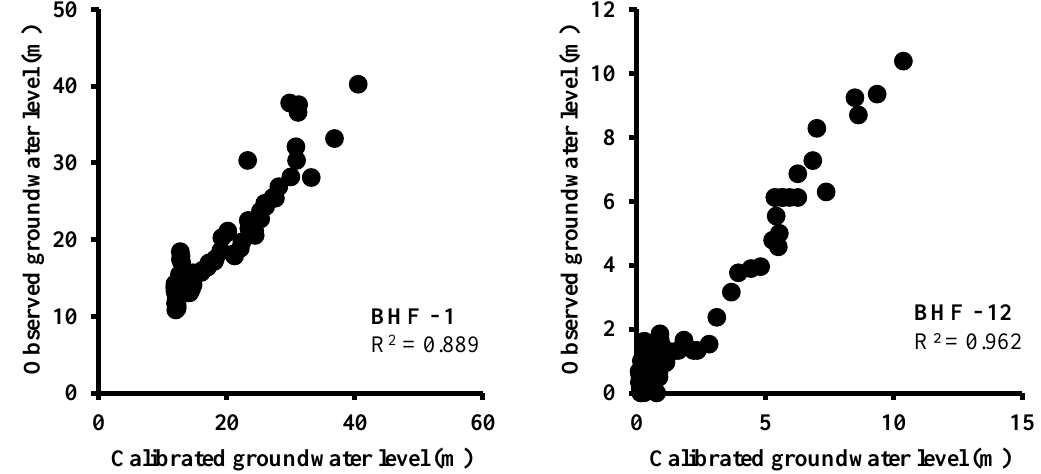
Figure 7. Observed and calibrated groundwater level at upstream (BHF-1) and at downstream (BHF- 12).